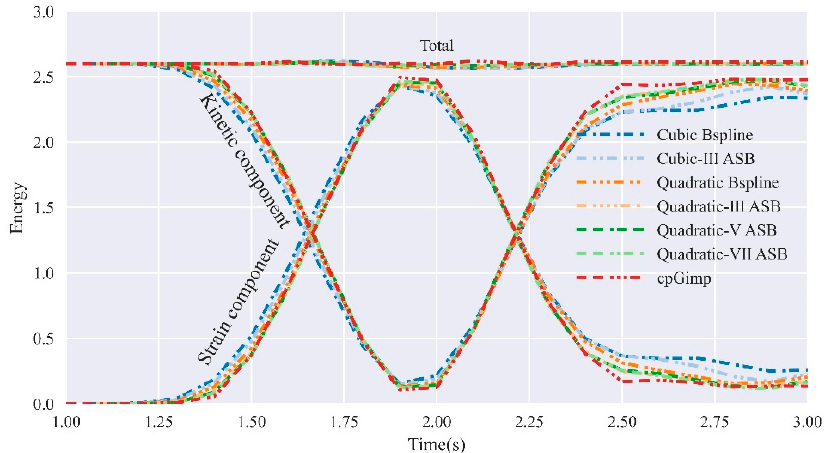
Figure 12. System energy comparison of 2D disks’ collision problem under different MPM shape functions.